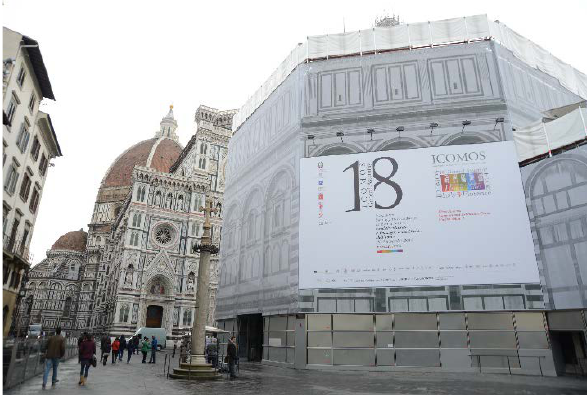
Figure 11: 2014 Declaration of Florence indicated that heritages has the power to drive urban redevelopment.